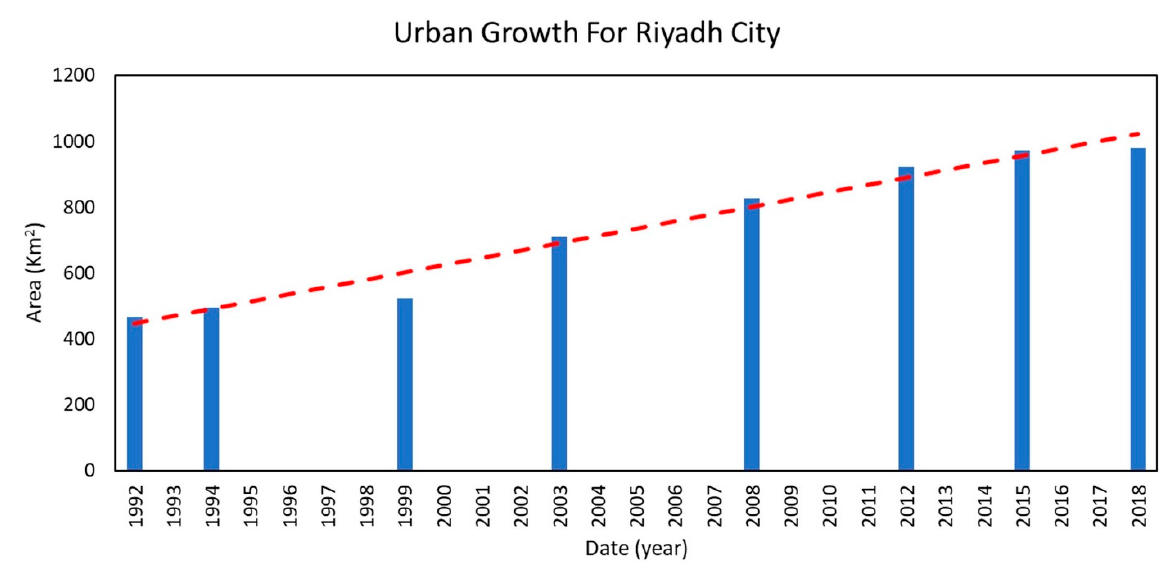
Figure 5. Urban growth (1992–2018) over study area extracted from the European Space Agency Climate Change Initiative (ESA-CCI) land cover viewer (http://maps.elie.ucl.ac.be/CCI/viewer/ accessed on 2 September 2020).